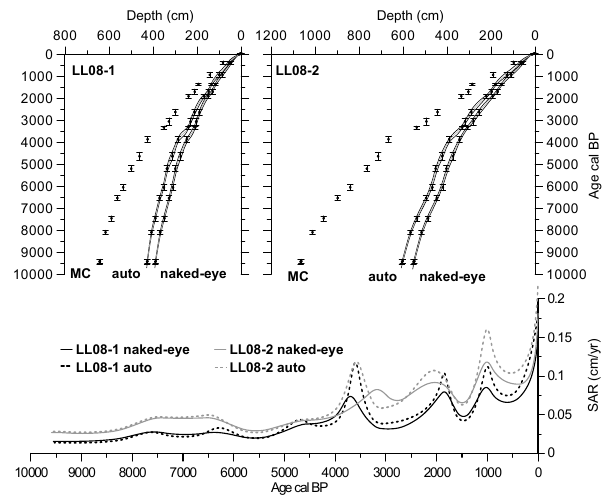
Fig. 3. Age/depth models and respective Sediment Accumulation Rate (SAR) from cores LL08-1 and LL08-2. MC: master core; Auto: without automatic count of flood deposits and naked-eye mass-wasting deposits; Naked-eye: without naked-eye count of sed- imentary events (flood deposits and mass-wasting deposits). For de- tailed explanation of both sedimentary events counting methods see Sect.